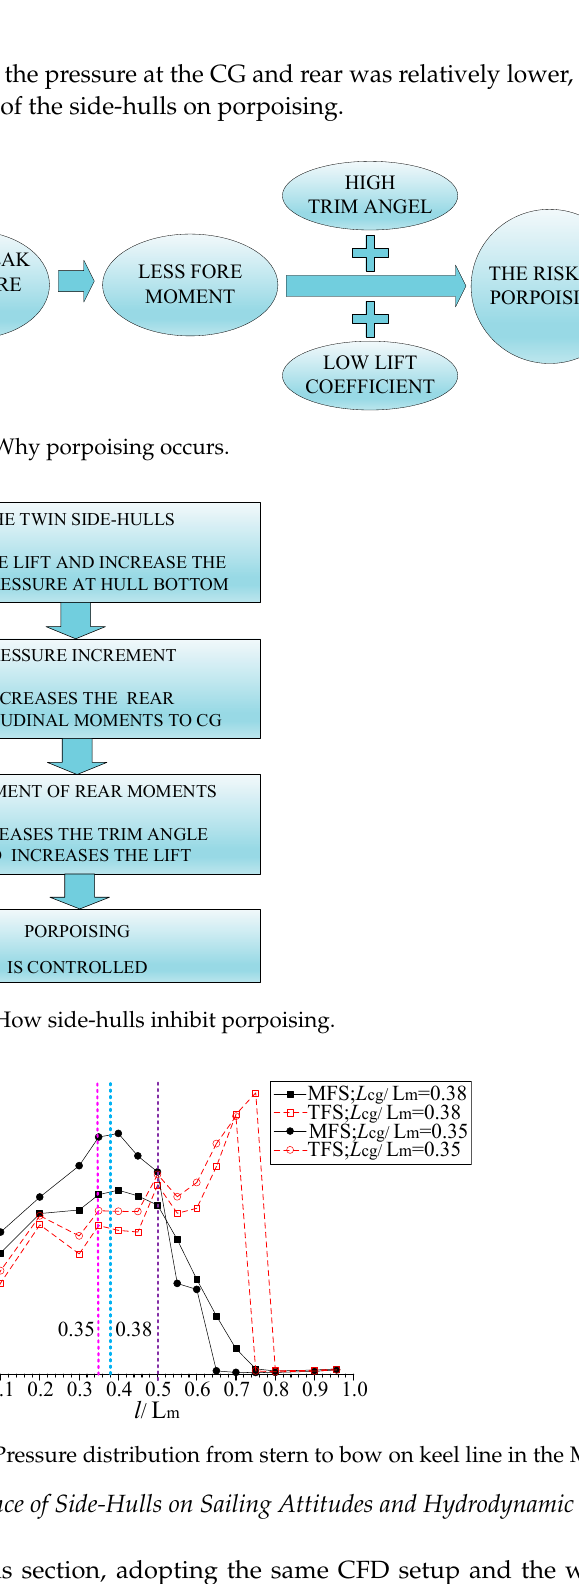
Figure 18. Forces and moment acted on the hull surface in the TFS.